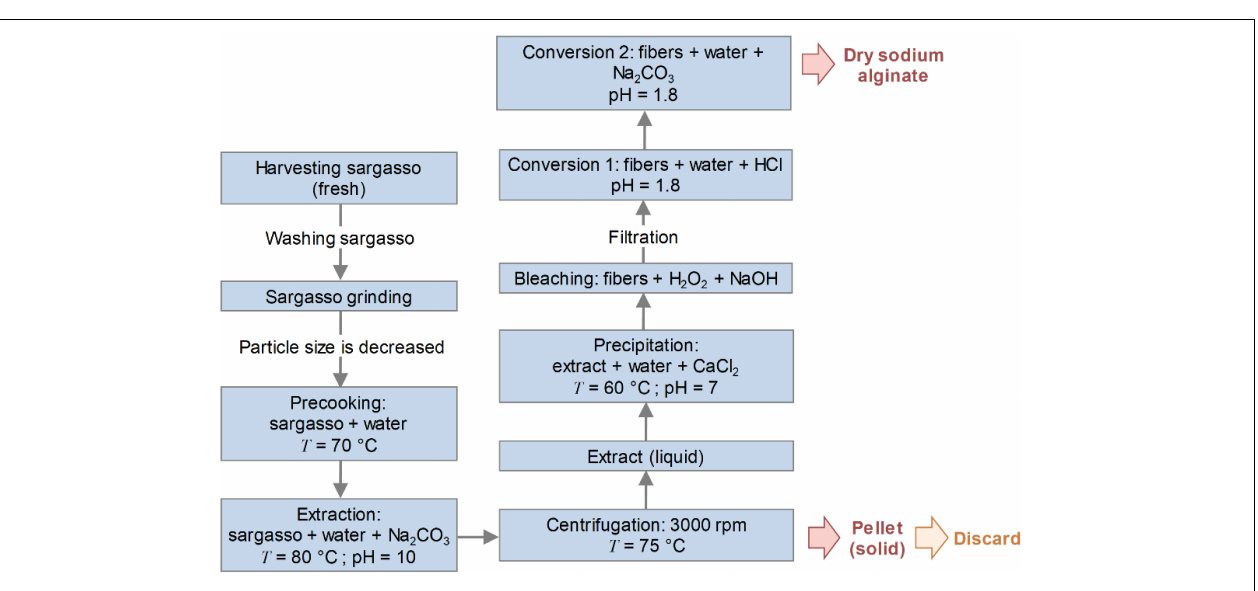
FIGURE 5 | The Creamos Más alginate extraction